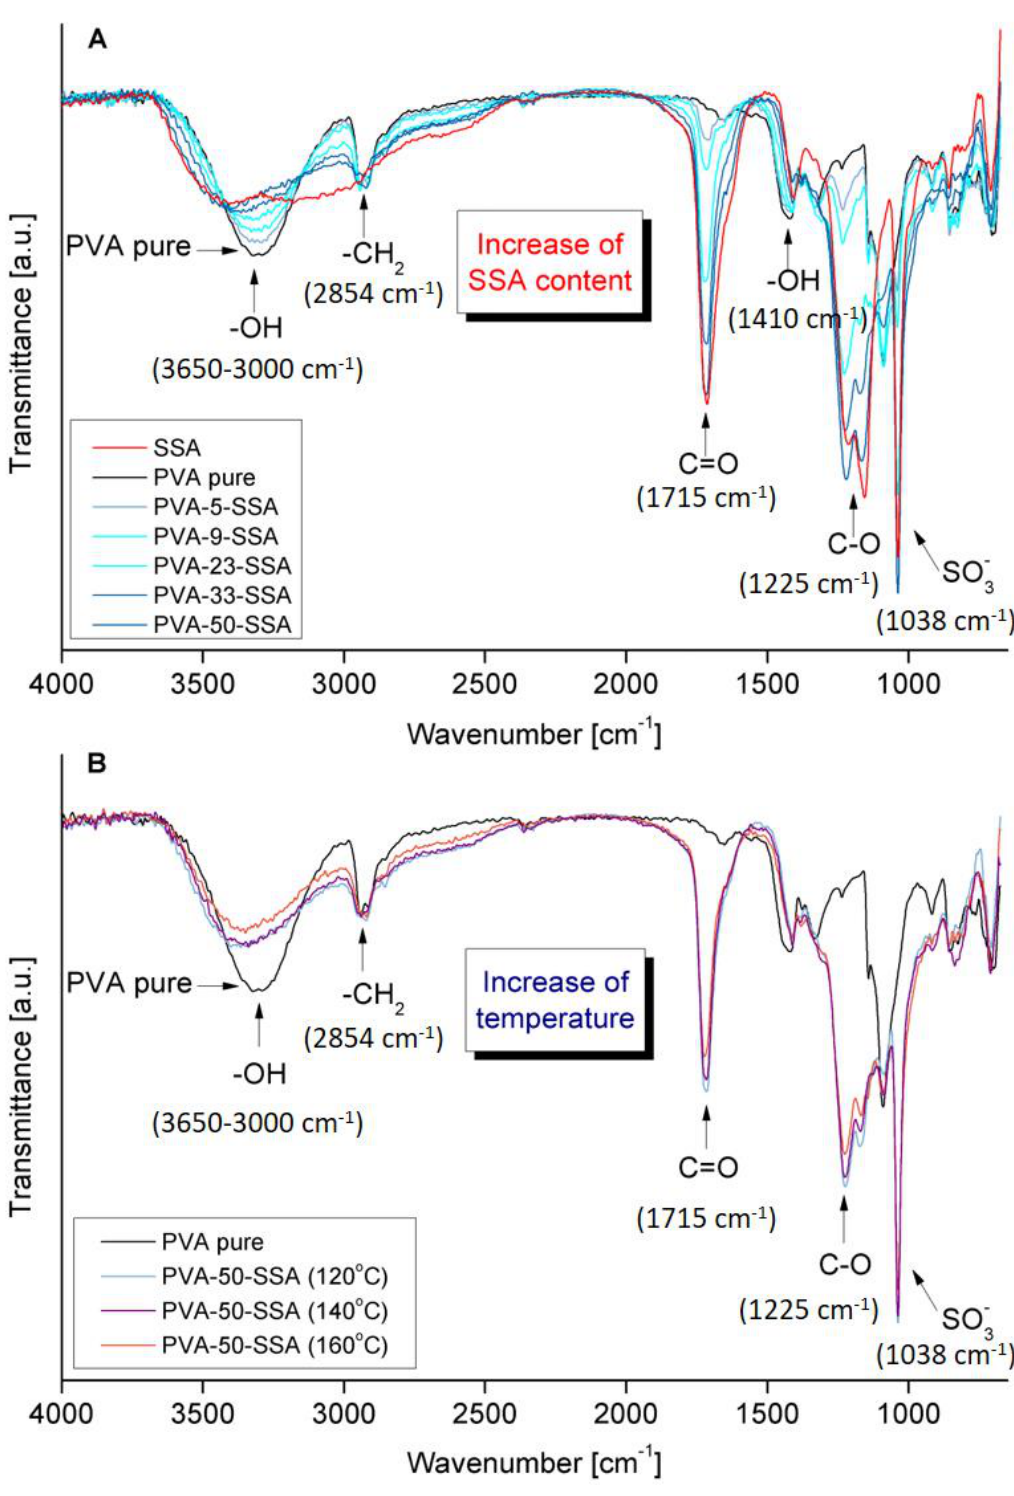
Figure 2. FTIR-ATR spectra of the crosslinked PVA-based membranes: ( A ) heat-treated at 120 °C as a function of the SSA content (5–50 wt.%) and ( B ) containing 50 wt.% SSA as a function of the crosslinking temperature (120–160 °C).